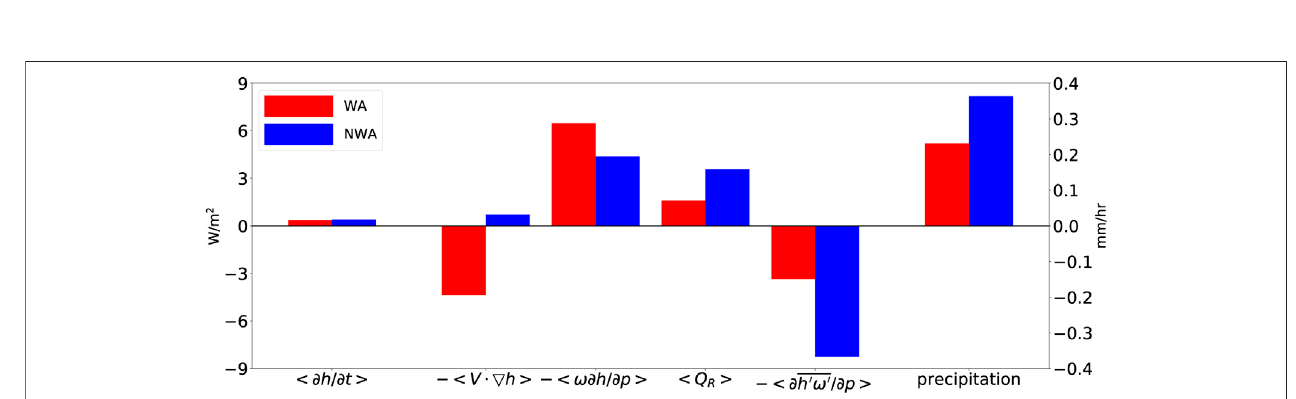
FIGURE 6 | Linear regression coef fi cients of the austral summer (DJF) mean PC1 with the MSE budget terms (W m − 2 ; 1981 – 2018) and the precipitation rate (mm hr − 1 ; TRMM 1998 – 2013) averaged over the NWA (blue bars) and WA (red bars) coastal regions.